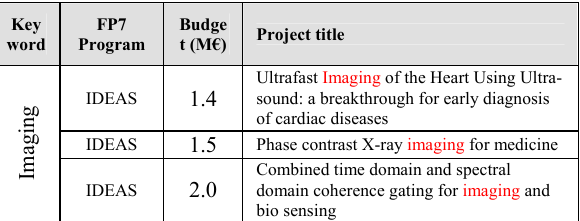
Table 2. EU FP7 funded Projects – In